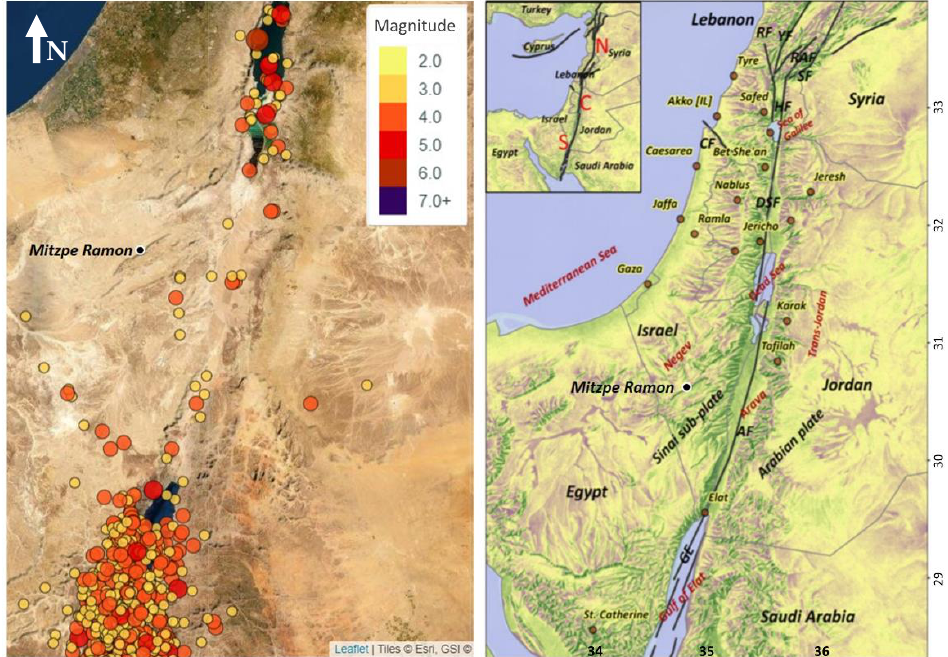
Figure 1. Location map. Right — regional seismogenic sources (active fault marked as black lines). Left — southern Israel seismicity (M > 3.5) of the past century and location of Mitzpe Ramon.